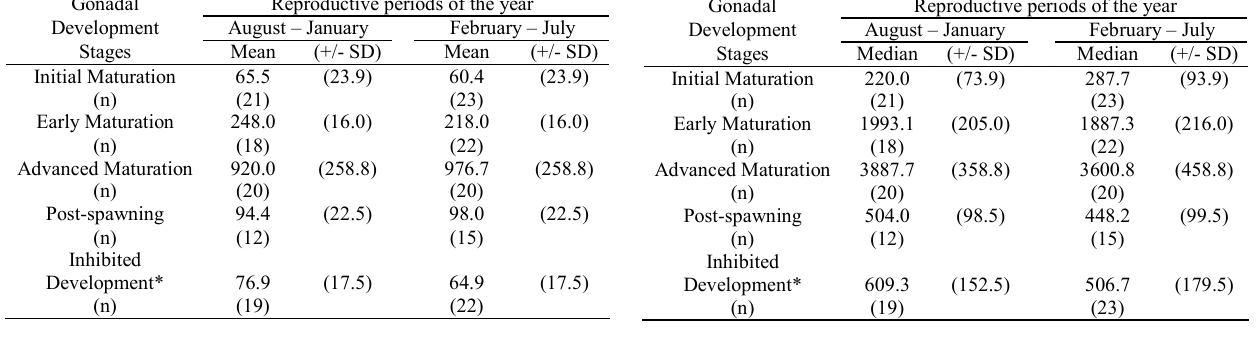
Table 2. Mean concentration (pg/ml) and standard deviation (+/- SD) of 17 beta-estradiol in non-infested females of Cy- phocharax gilbert in different gonadal development stages and in infested females (*) from rio Itabapoana, Brazil, col- lected from August 1997 to July 2000.